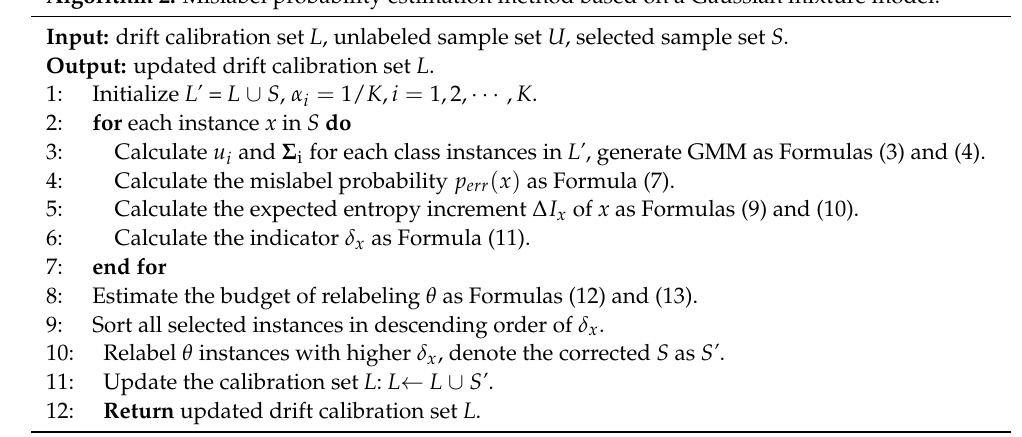
Algorithm 2. Mislabel probability estimation method based on a Gaussian mixture